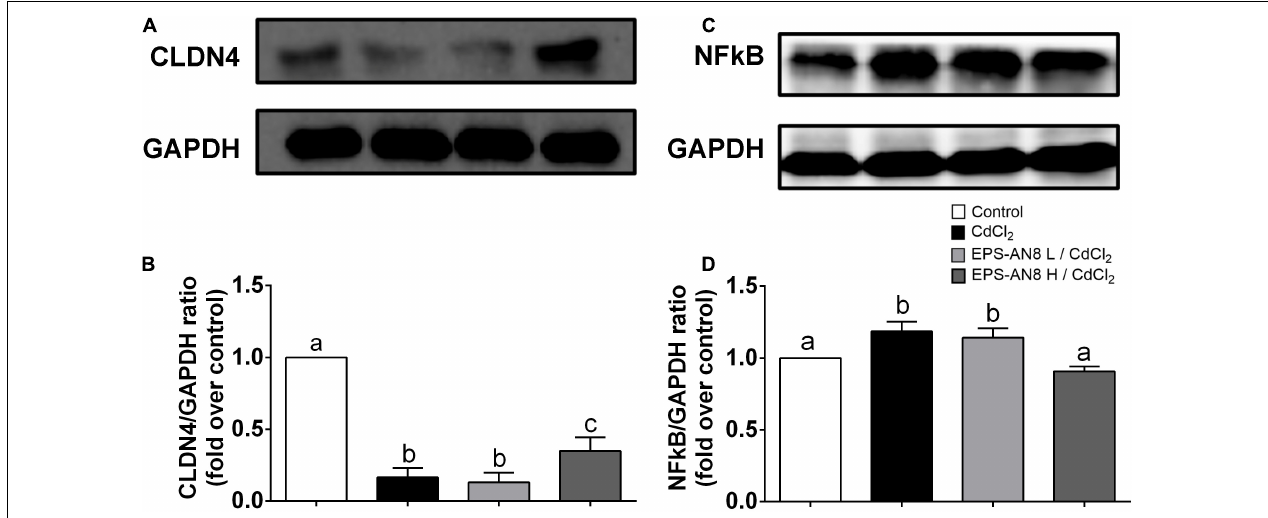
FIGURE 6 | EPS-AN8 as a potential agent for alleviation of Cd-induced damage. (A,B) Effect of EPS (L and H) on Cd-induced down-regulation of tight junction protein CLDN-4 and representative Western blot and densitometric analysis, respectively. (C,D) Effect of EPS (L and H) on Cd-induced overexpression of NF- κ B and representative Western blot and densitometric analysis, respectively. Values that do not share a common letter are significantly ( p < 0.05)